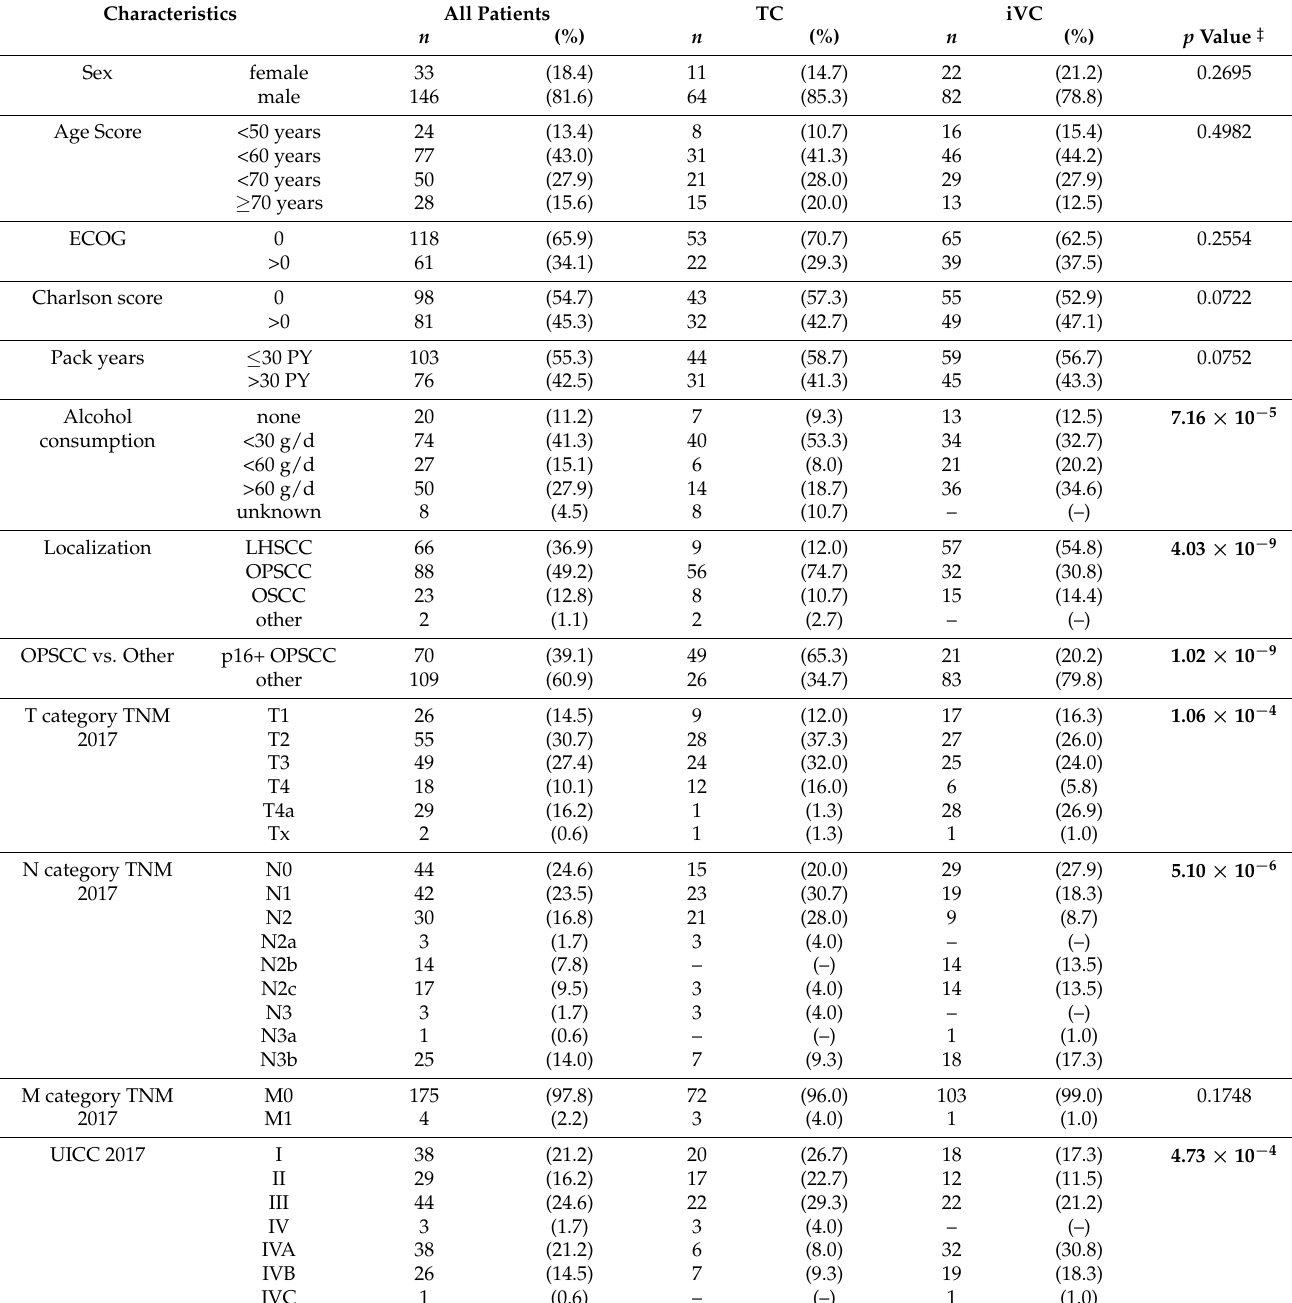
Table 2. Characteristics of HNSCC patients in the test cohort (TC; n = 75) and independent validation cohort (iVC; n = 104). Significant differences between groups ( p < 0.05) in Pearson’s Chi-square tests are highlighted